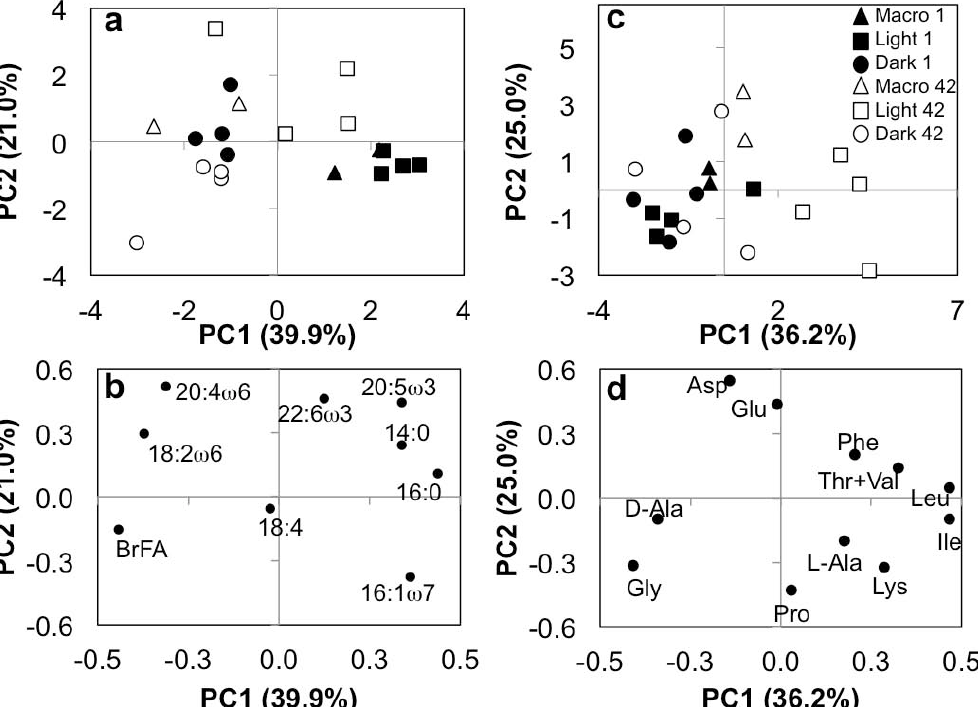
Fig. 7. Score and loading results for PC1 and PC2 from PCA analyses. Scores (a) and loadings (b) for PLFA data and scores (c) and loadings (d) for HAA data are shown. Filled symbols in the score plots represent Day 1 observations and open symbols represent Day 42. Treatments are Macro (triangles), Light (squares) and Dark (circles). In (b) , PLFA such as 14:0, 20:5 ω 3, and 16:1 ω 7, which derive from a variety of aquatic microbes, had the most positive loadings on PC1, while BrFA (bacterial sources) had the most negative loadings on PC1. PUFA had the most positive loadings on PC2. In (d) , Leu and Ile had the most positive loadings on PC1 while loadings for Gly and D-Ala (bacteria) were the most negative. Asp and Glu had positive loadings on PC2 while Pro, Gly, and Lys had negative loadings on